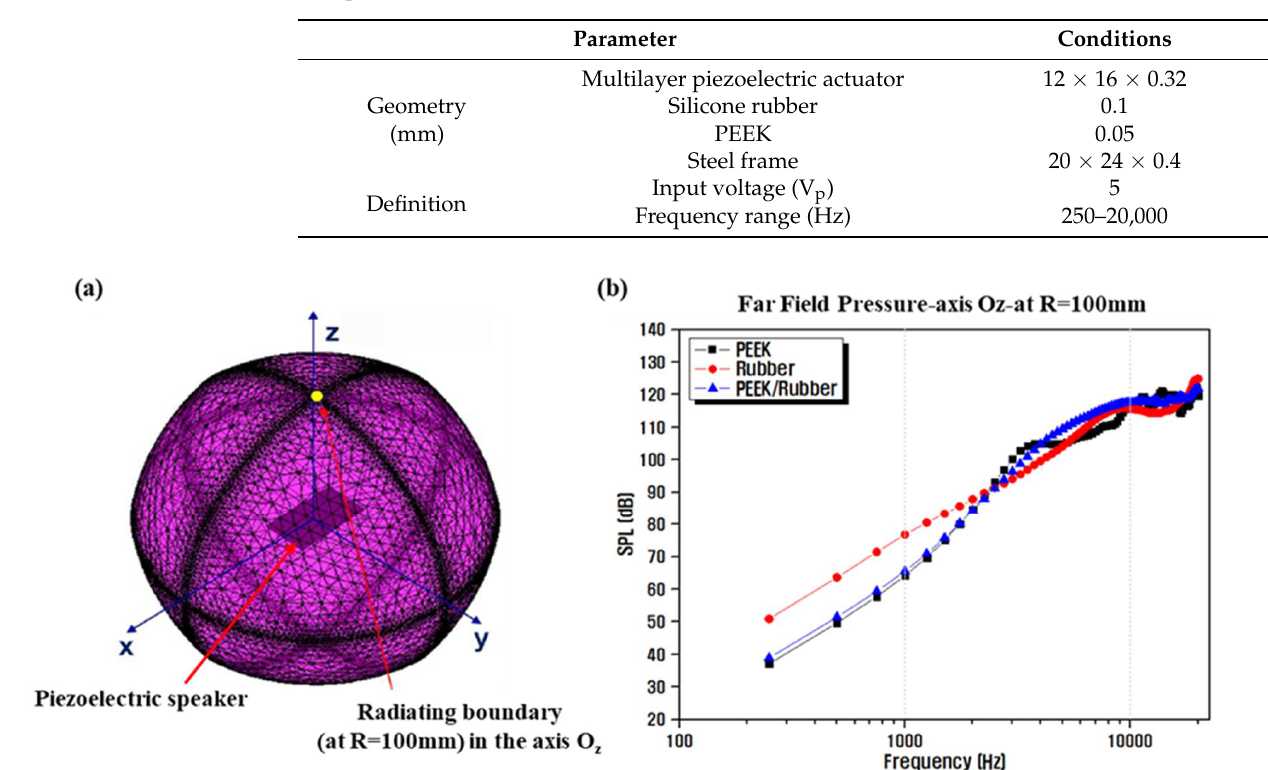
Figure 6. ( a ) Finite element model for the numerical analysis of the investigated piezoelectric speaker, and ( b ) the calculated frequency response characteristics of the acoustic diaphragms of the piezoelectric speaker.